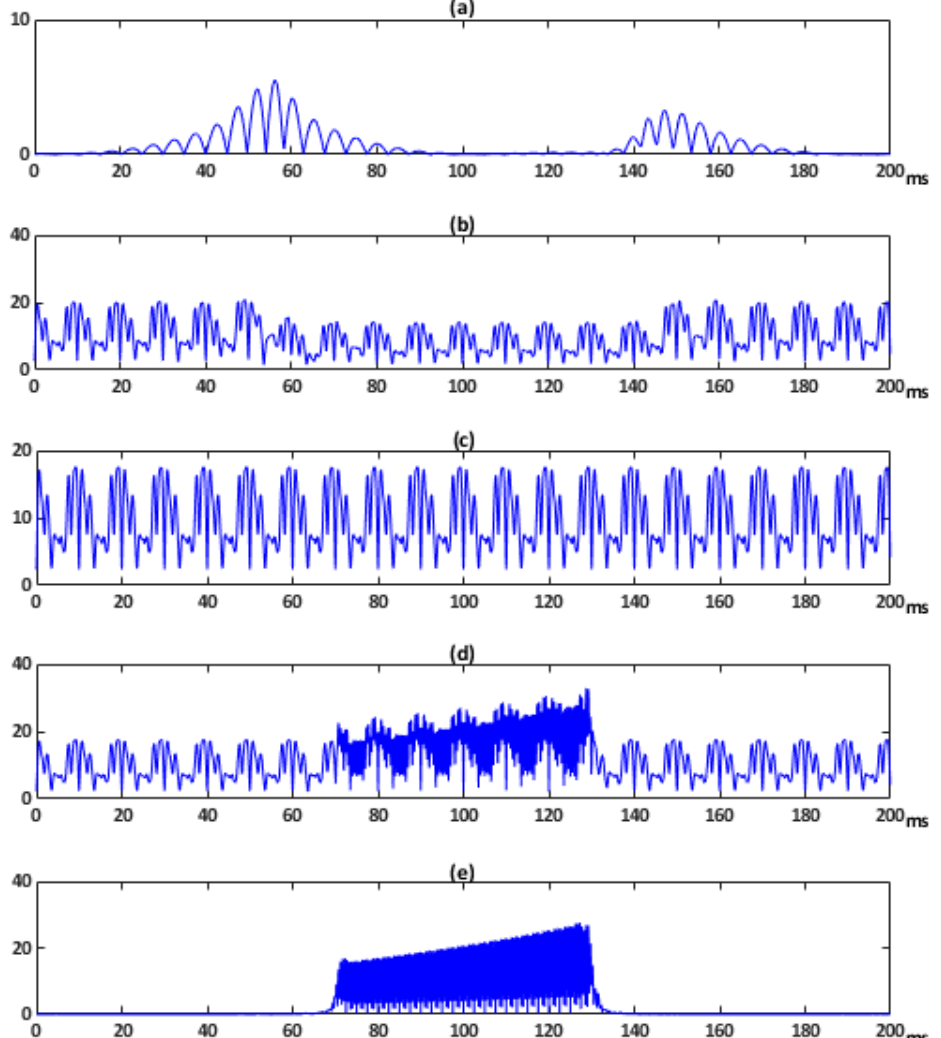
Figure 9. Instantaneous Transient Disturbance ratio index ITD ( t ) of voltage disturbances combina- tion.